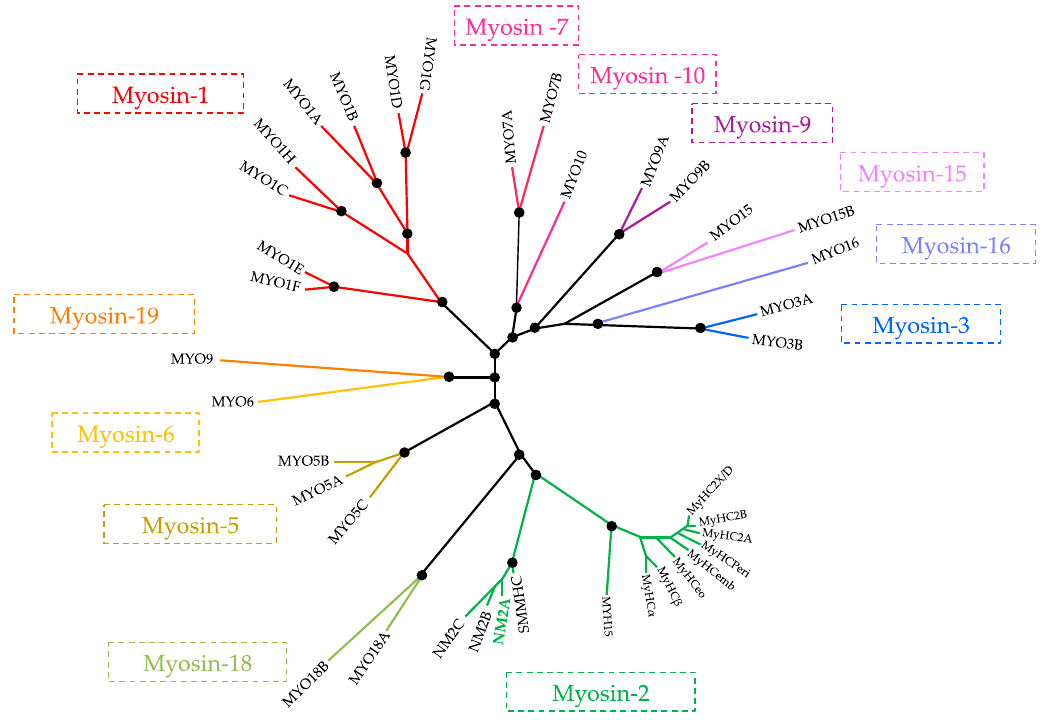
Figure 1. Phylogenetic tree of the myosin superfamily in humans. The 38 human genes that encode the diverse myosins are identified. The sequences of the myosin motor domains were analyzed and grouped phylogenetically allowing the distribution of myosins into 12 different classes. This figure was adapted from [8] .